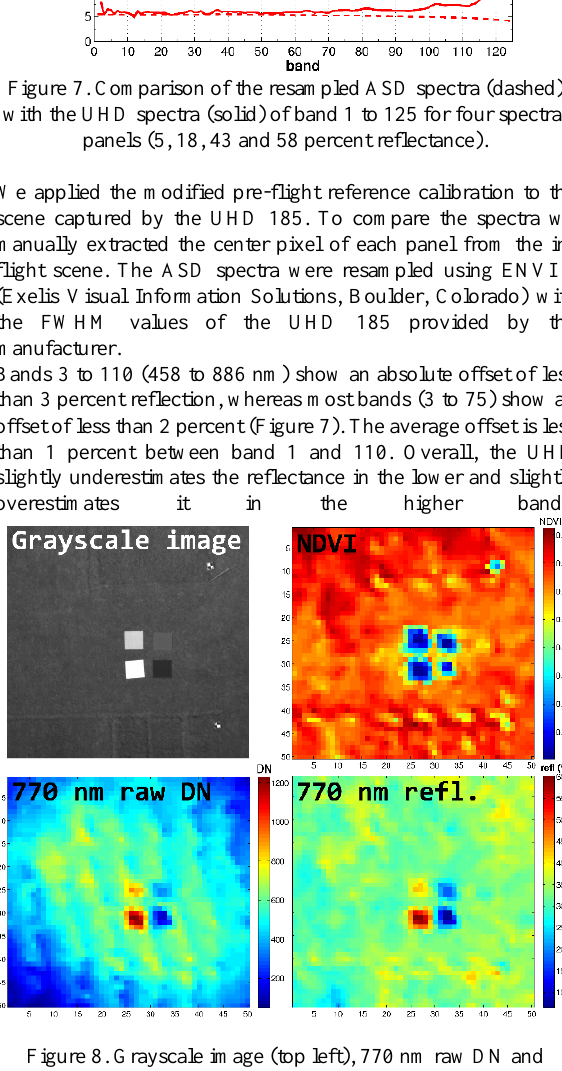
Figure 8. Grayscale image (top left), 770 nm raw DN and reflectance (bottom left and right) and NDVI from a scene with four calibration panels (top